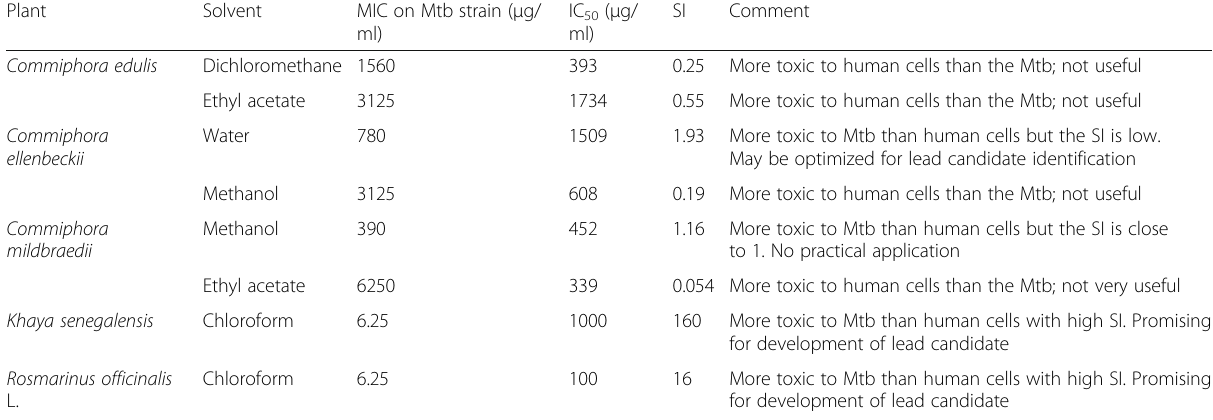
Table 4 Selectivity indices of some antitubercular plant species reported in East Africa Plant